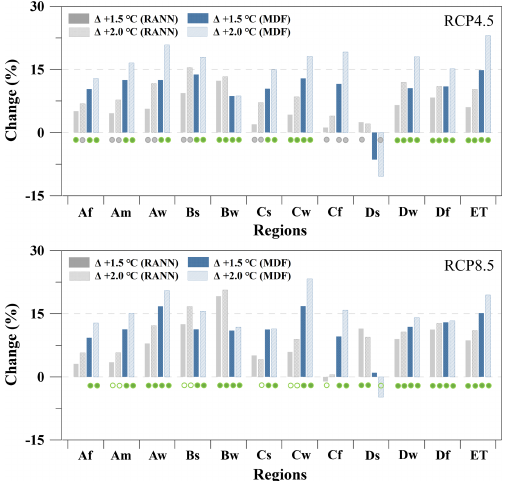
Figure 11. Relative changes in the (a) annual mean runoff (RANN) and (b) annual maximum runoff (MDF) for the 12 climate zones derived from the MME of the five GCMs under 1.5 and 2.0 ◦ C of global warming compared to the reference period (REF). Green cir- cles (gray circles) denote 100% (over 80%) intermodel